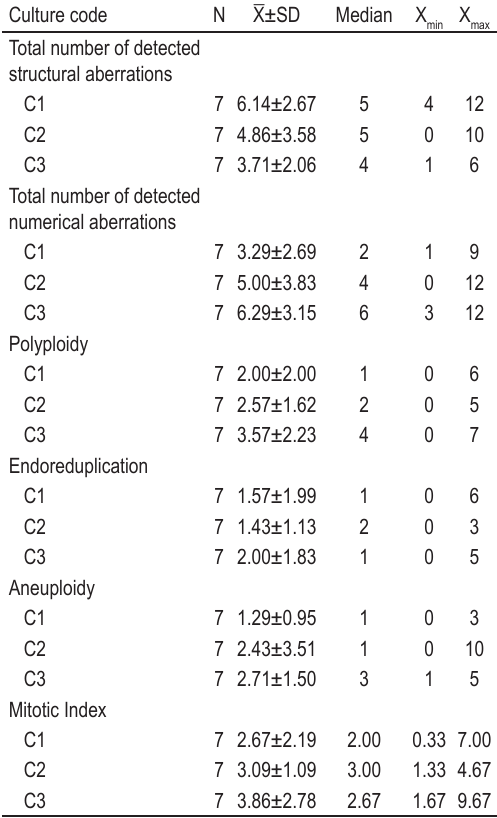
TABLE 2. The core descriptive statistic for detected